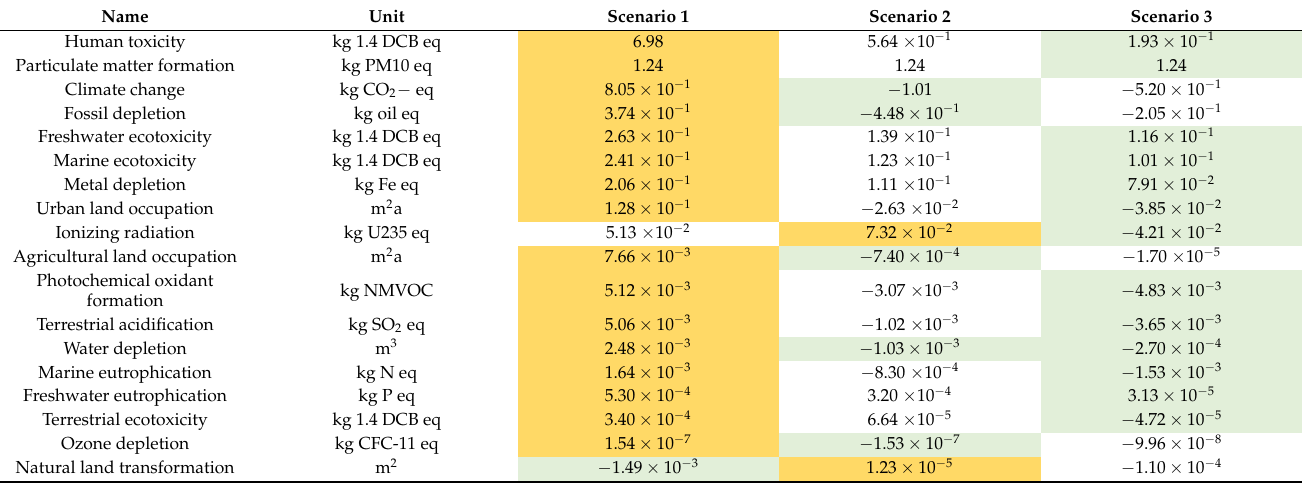
Table 6. Environmental impacts calculated according to the ReCiPe Midpoint (H) method for Scenario 1 (GS disposal in landfills), Scenario 2 (GS valorised as a substitute for feldspar in ceramic materials), Scenario 3 (GS valorised as a substitute for fine–medium inert filler in concrete mix). Yellow cells indicate the highest values, and light green are the lowest values obtained for each impact category, respectively. All values are referred to the functional unit 1 m 2 granite